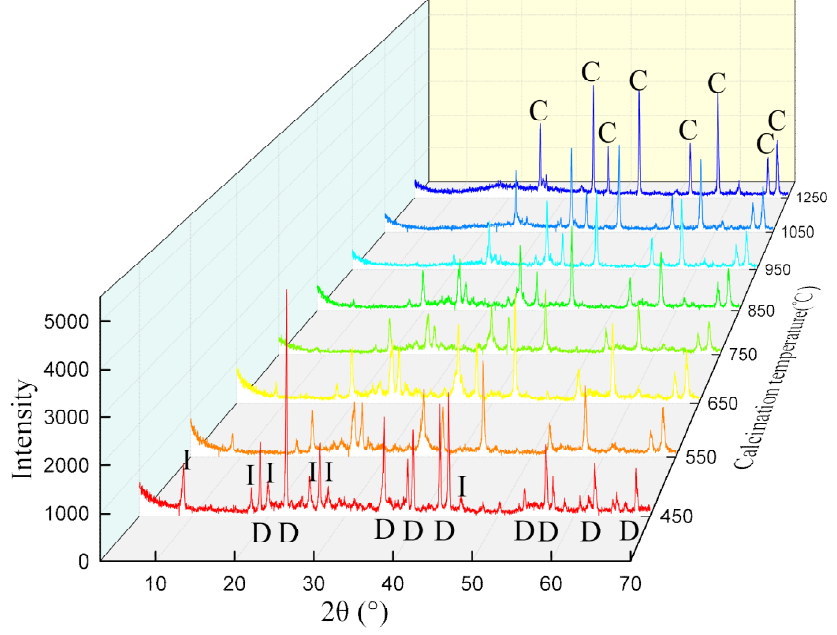
Figure 5. XRD pattern of the bauxite calcined at different temperatures. (D, diaspore. I, illite. C, corundum).